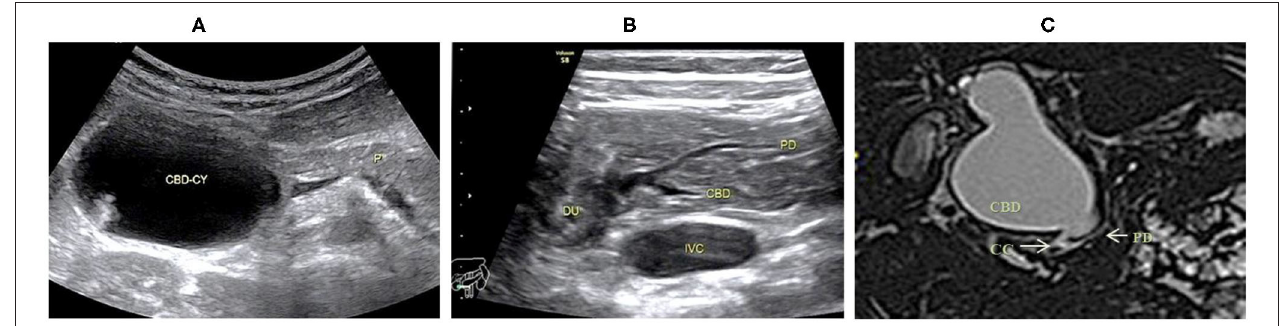
FIGURE 1 | Images of a representative type A of PBM. (A) US transverse scan showed the dilated CBD containing the protein plugs; (B) US transverse scan showed the PD joining the terminal stenotic CBD within pancreas to form a common channel which drains into the duodenum; (C) MRCP indicated the dilated CBD with a narrow distal end joining the common channel.